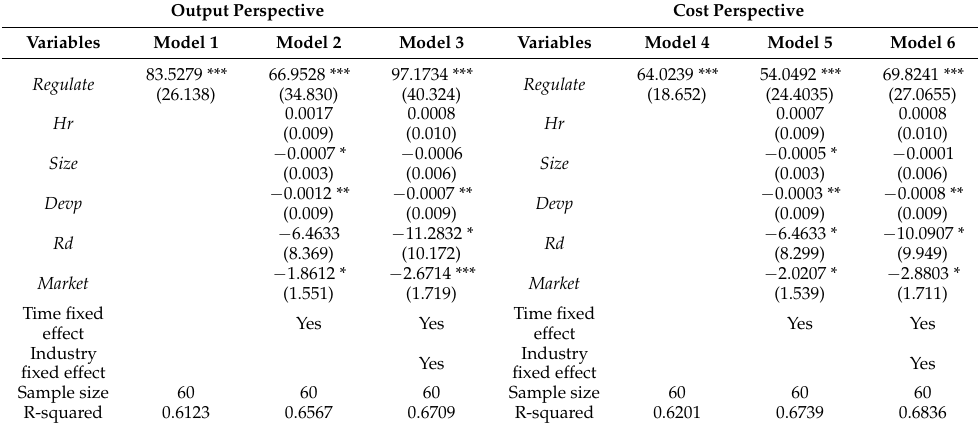
Table 3. Regression results of the benchmark